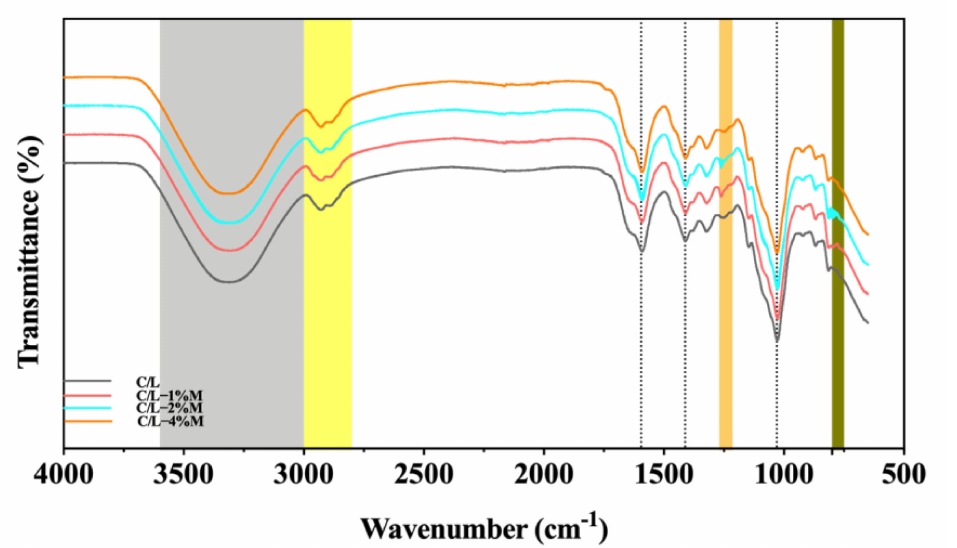
Figure 3. Fourier transform infrared patterns of carboxymethyl chitosan/locust bean gum and carboxymethyl chitosan/locust bean gum/ Melissa officinalis L. essential oil films. (C/L: coated with C/L active coating solution without MOEO nano-emulsions; C/L-1%M: coated with C/L active coating solution containing 1% MOEO nano-emulsions; C/L-2%M: coated with C/L active coating solution containing 2% MOEO nano-emulsions; and C/L-4%M: coated with C/L active